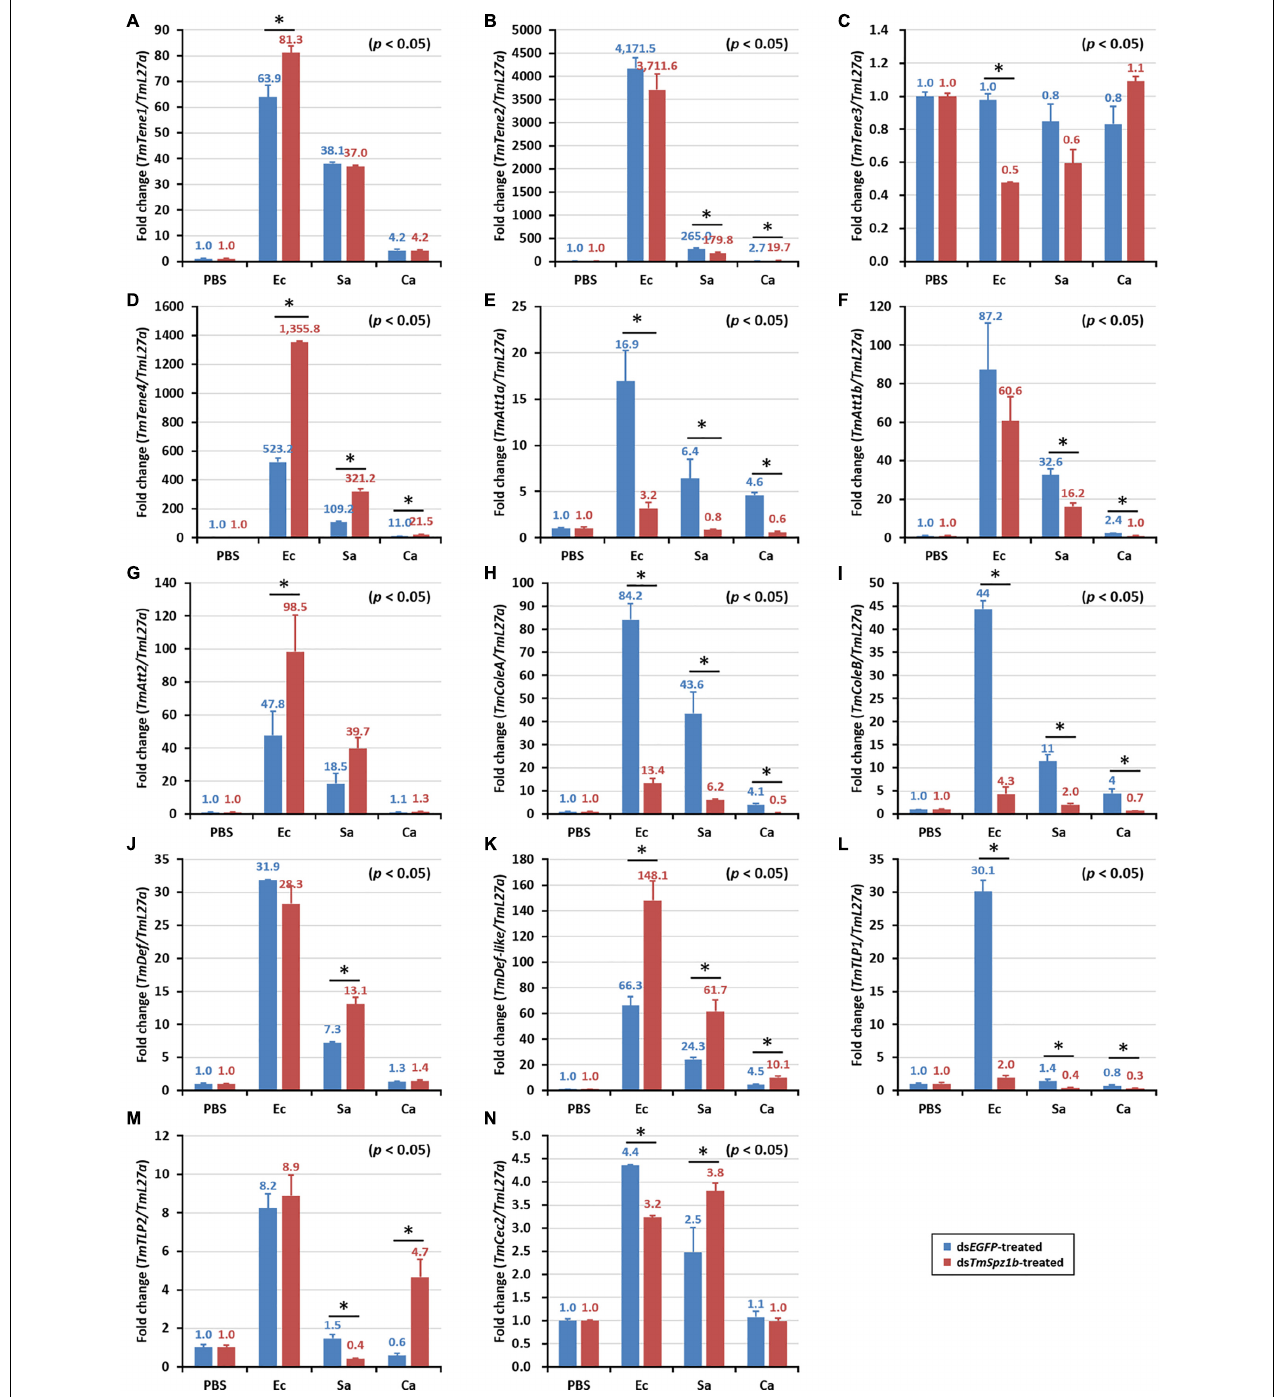
FIGURE 7 | Effects of TmSpz1b gene-silencing on the expression of 14 AMP genes in response to pathogen injection in fat body. E. coli, S. aureus, and C. albicans were injected into ds TmSpz1b -treated T. molitor larvae. The expression levels of 14 AMP genes were determined at 24 h post injection, by qRT-PCR. In fat bodies, five AMP genes ( TmAttacin1a , and 1b , TmColeoptericin1 and 2, and TmTLP1 ) were significantly decreased by TmSpz1b RNAi. dsEGFP was injected as a negative control and TmL27a was used as an internal control. All experiments were performed in triplicate. Asterisks indicate significant differences between ds TmSpz1b and ds EGFP -treated groups when compared by Student’s t -test ( P < 0.05). TmTene1 ( A ; TmTeneecin-1 ), TmTene2 ( B ; TmTenecin-2 ). TmTene3 ( C ; TmTenecin-3 ), TmTene4 ( D ; TmTenecin-4 ), TmAtt1a ( E ; TmAttacin-1a ), TmAtt1b ( F ; TmAttacin-1b ), TmAtt2 ( G ; TmAttacin-2 ), TmCole1 ( H ; TmColeoptericin-1 ), TmCole2 ( I ; TmColeoptericin-2 ), TmDef1 ( J ; TmDefensin-1 ), TmDef2 ( K ; TmDefensin-2 ), TmTLP1 ( L ; TmThaumatin-like protein-1 ), TmTLP2 ( M ; TmThaumatin-like protein-2 ), TmCec2 ( N ; TmCecropin-2 ).